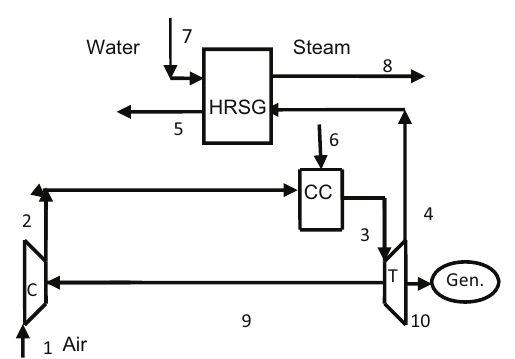
Figure 1: General diagram of the basic ( bsc ) cogeneration